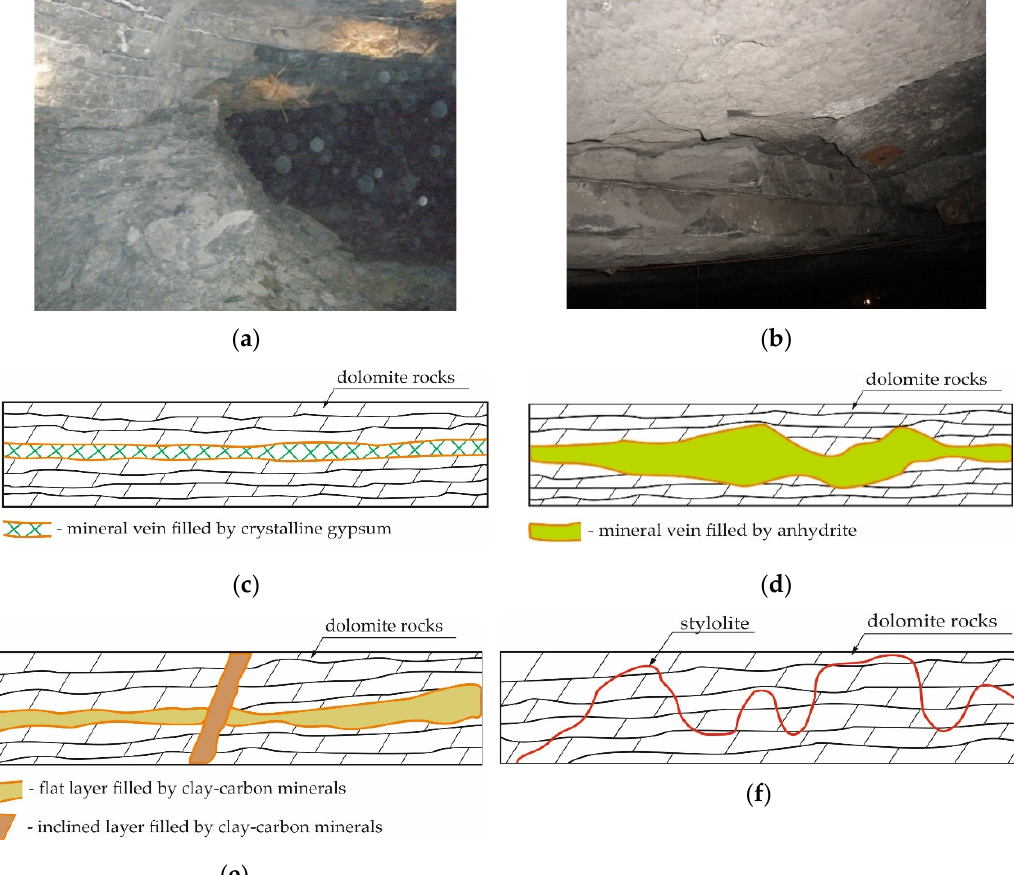
Figure 3. Characteristic structural forms of carbonate rocks: ( a ) stratification of the pillar; ( b ) stratification of the roof; ( c ) mineral vein filled by crystalline gypsum; ( d ) mineral vein filled by ahydrite; ( e ) flat and inclined layers filled with clay-carbon minerals; ( f ) stylolite, crossing layers.